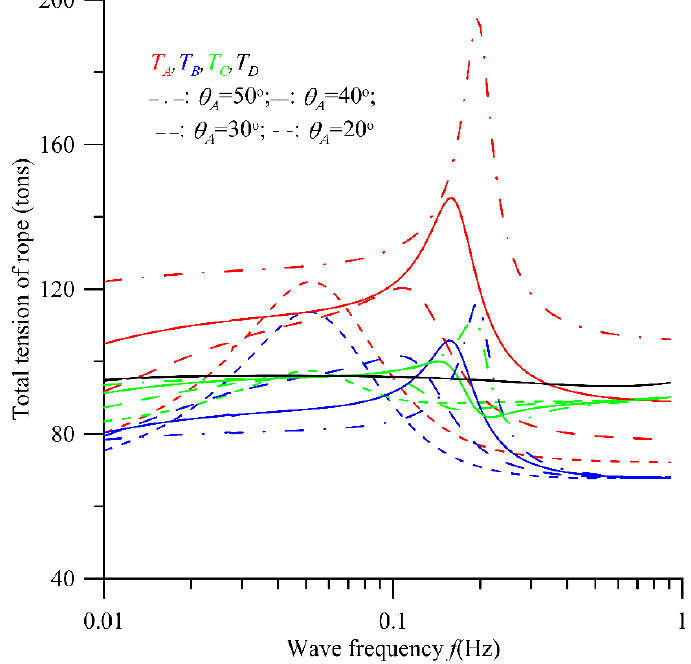
Figure 18. Spectrum of total tension of rope ( P T 1 == ).